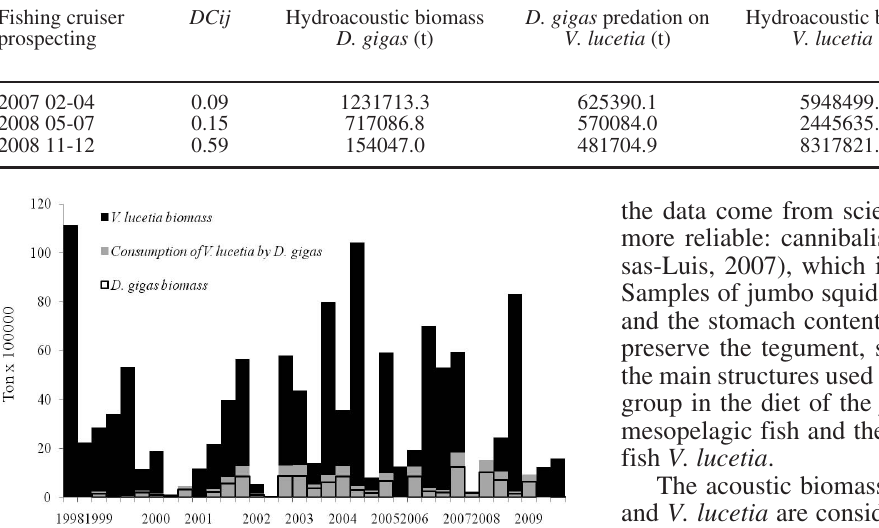
Table 3. – Acoustic biomass estimation of jumbo squid and V. lucetia , and estimated consumption of V. lucetia by D. gigas between 2007 and 2008. Q/B of jumbo squid= 5.8, taken from Alarcon-Muñoz et al. (2008). Fishing cruiser